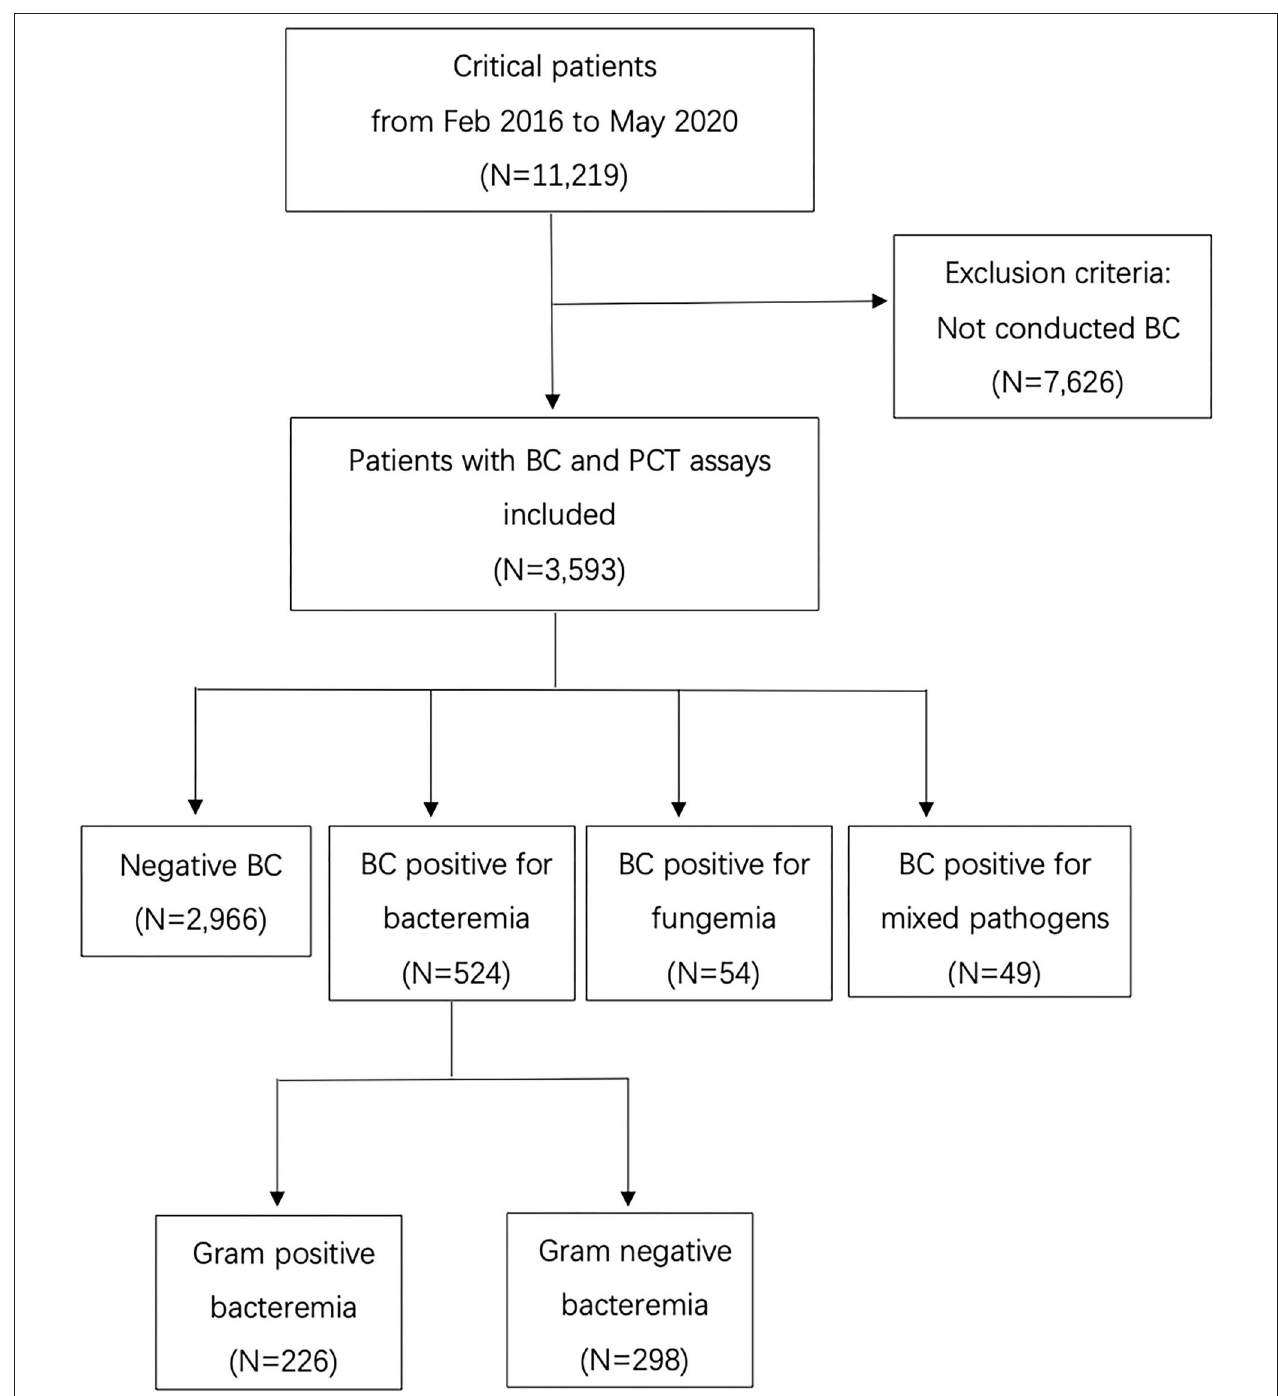
FIGURE 1 | Flow chart of the inclusion and exclusion of patients (BC, Blood culture; PCT,